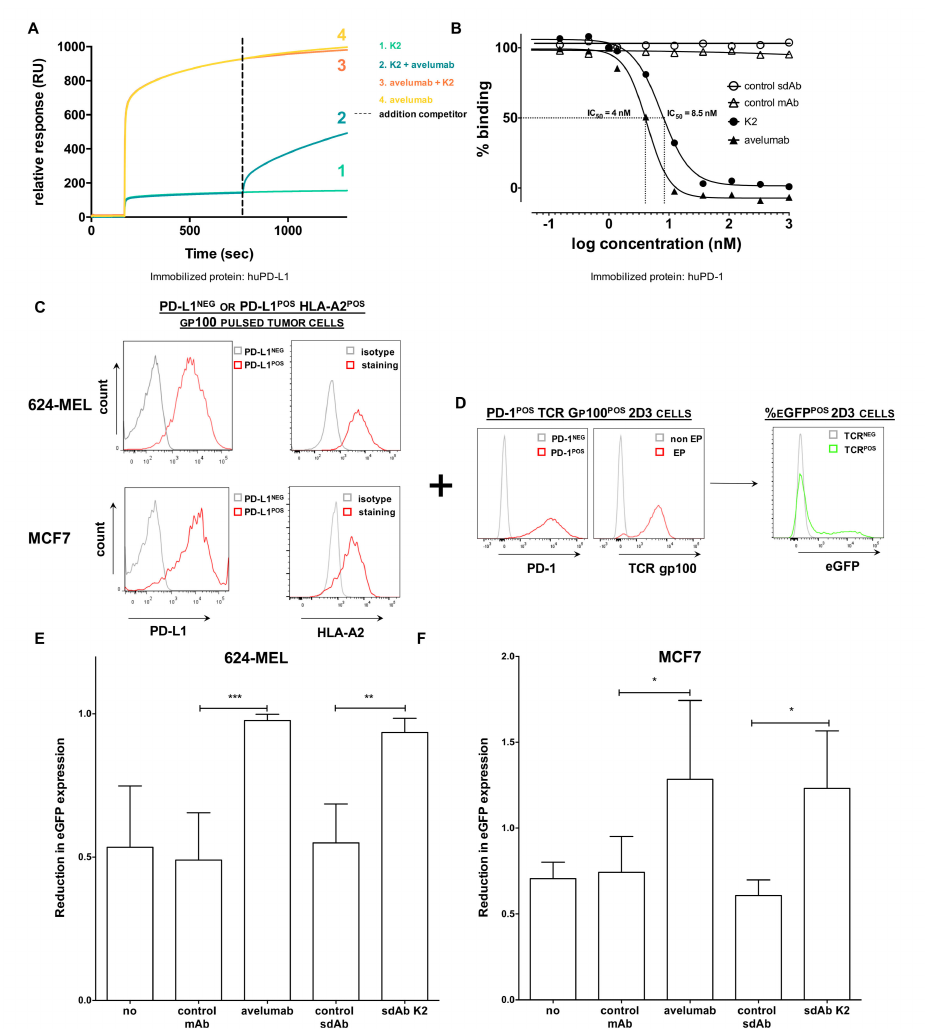
Figure 6. sdAb K2 and avelumab antagonize PD-1:PD-L1 interactions. ( A ) A competition study with equimolar amounts of avelumab and sdAb K2 shows that both bind the same epitope on human PD-L1 as determined by SPR. ( B ) Dose response curves of soluble recombinant human PD-L1 protein mixed with increasing concentrations of sdAb K2, control sdAb, avelumab or control mAb, to immobilized human PD-1 recombinant protein, as determined by SPR. Per condition, maximal signal is shown relative to the sample that only contains recombinant PD-L1 protein. A representative experiment out of two independent experiments is shown. ( C , D ) Schematic representation of the experimental set up of the PD-1 POS 2D3 reporter assay. ( C ) Representative flow cytometry histograms showing PD-L1 and HLA-A2 expression in HLA-A2 POS PD-L1 NEG (grey) or HLA-A2 POS PD-L1 POS (red) 624-MEL or MCF7 cells. ( D ) Representative flow cytometry histograms showing PD-1 NEG (grey) or PD-1 POS (red) 2D3 cells electroporated with mRNA encoding a TCR recognizing gp100 in the context of HLA-A2 (red). HLA-A2 POS PD-L1 POS or HLA-A2 POS PD-L1 NEG 624-MEL or MCF7 cells are pulsed with a human gp100 280–288 peptide. These cells are co-cultured with PD-1 POS 2D3 cells expressing a TCR αβ recognizing gp100 280–288 in the context of HLA-A2 either or not in combination with 360 nM of sdAbs or mAbs. When the gp100 280–288 peptide is recognized by the TCR on the 2D3 cells, this will lead to eGFP upregulation by the 2D3 cells ( right ). ( E , F ) Both avelumab and sdAb K2 revert the suppressive effect of PD-L1 expressed on 624-MEL ( E ) or MCF7 ( F ) cells on the activation of PD-1 POS 2D3 reporter cells. The graphs depict the reduction in eGFP expression by PD-1 POS 2D3 cells when co-cultured with PD-L1 POS cancer cells compared to their co-culture with PD-L1 NEG cancer cells (mean ± SEM, n = 3). No treatment, a control sdAb or an isotype control mAb served as negative controls. Percentage eGFP POS CD8 POS PD-1 POS 2D3 cells was evaluated using flow cytometry. * p < 0.05, ** p < 0.01, *** p <